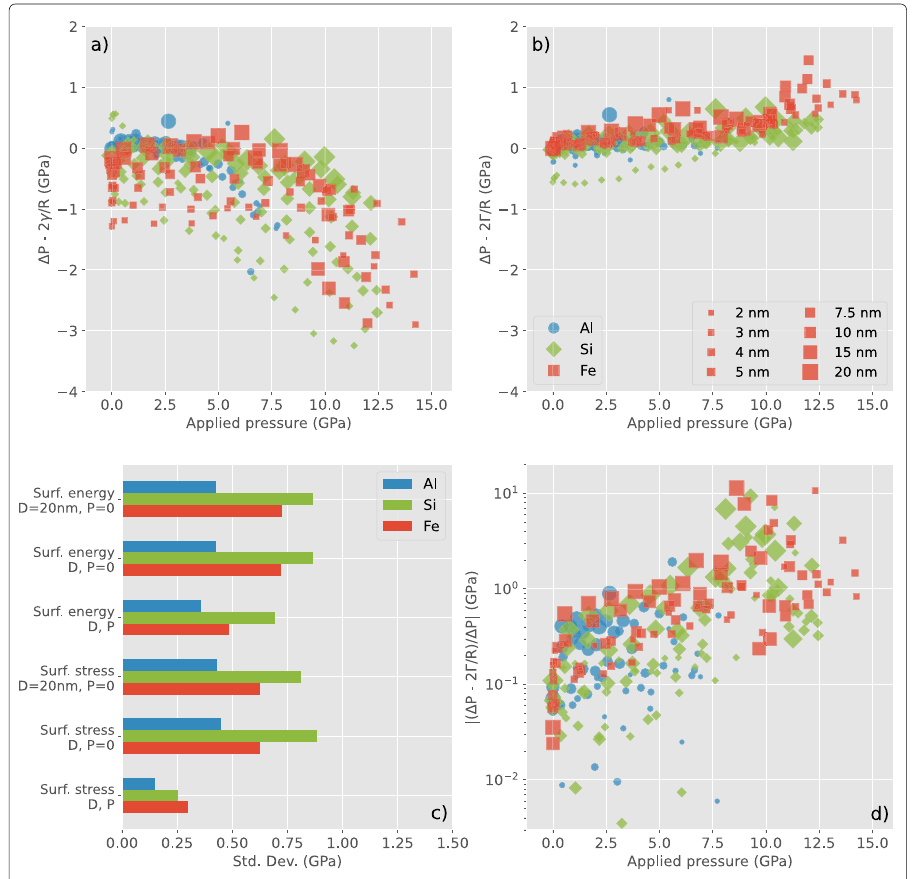
Fig. 8 a) Difference between (cid:2) P and the Laplace pressure for cavities as a function of the applied pressure (Blue circles: Al, green diamond: Si, red squares: Fe). The symbol size is proportional to the diameter. The surface energy of the 20 nm diameter cavity is used to calculate the Laplace pressure. b) same quantity and representation than in a), except that the diameter and pressure dependent surface stress value is now used to compute the Laplace pressure. c) Standard deviation for differences between (cid:2) P and the Laplace pressure for cavities. Each set of bars corresponds to a specific choice for the surface energy/stress used to compute the Laplace pressure (see text for details). d): Relative difference between (cid:2) P and the Laplace pressure